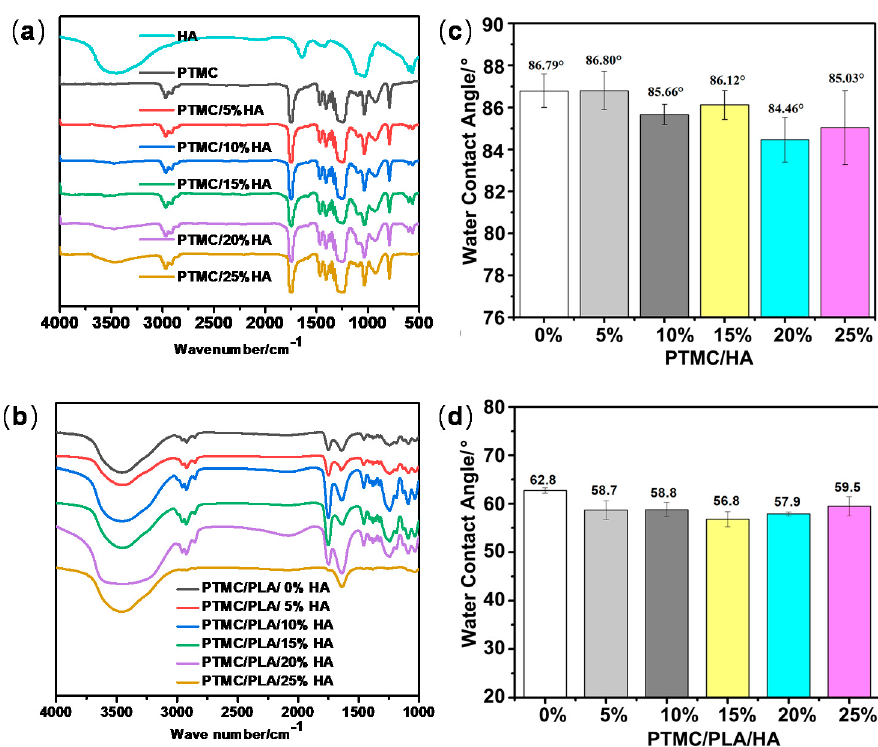
Figure 1. FT-IR ( a ) and water contact angle ( c ) of PTMC/HA; FT-IR ( b ) and water contact angle ( d ) of PTMC/PLA/HA scaffolds.